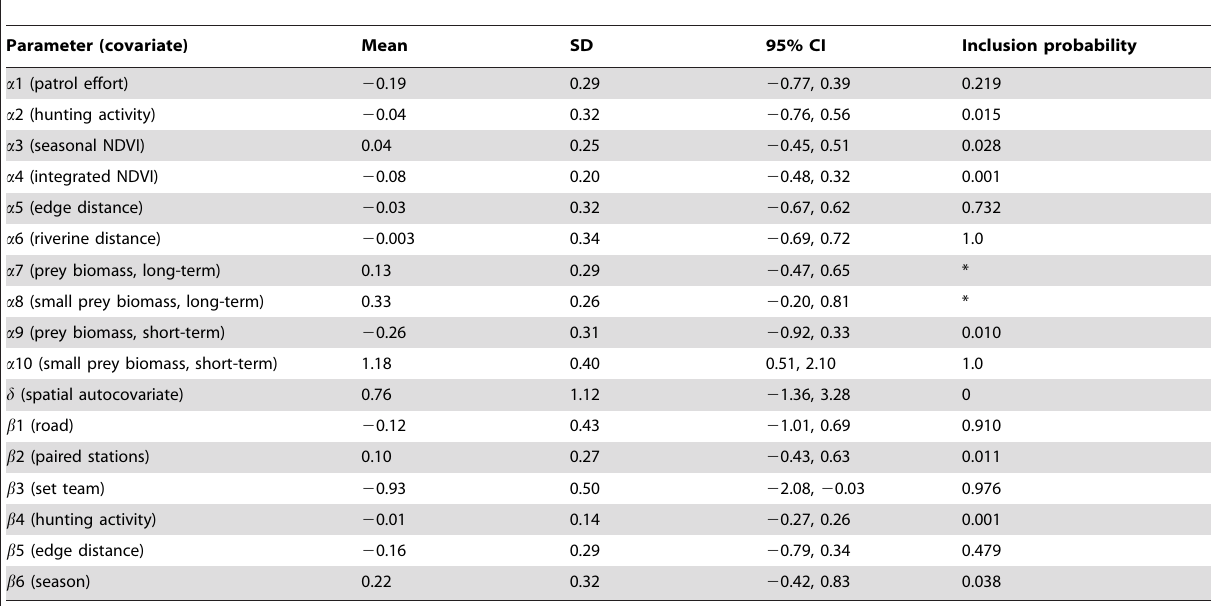
Table 3. Posterior probability summaries of hyper-parameters for mean community-level effects of hypothesized site covariates on carnivore occurrence ( a and d coefficients) and detection ( b